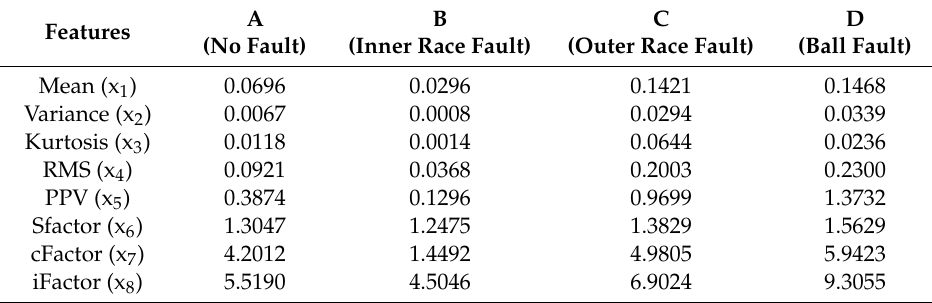
Table 4. Estimated Cluster centers of statistical features for di ff erent bearing